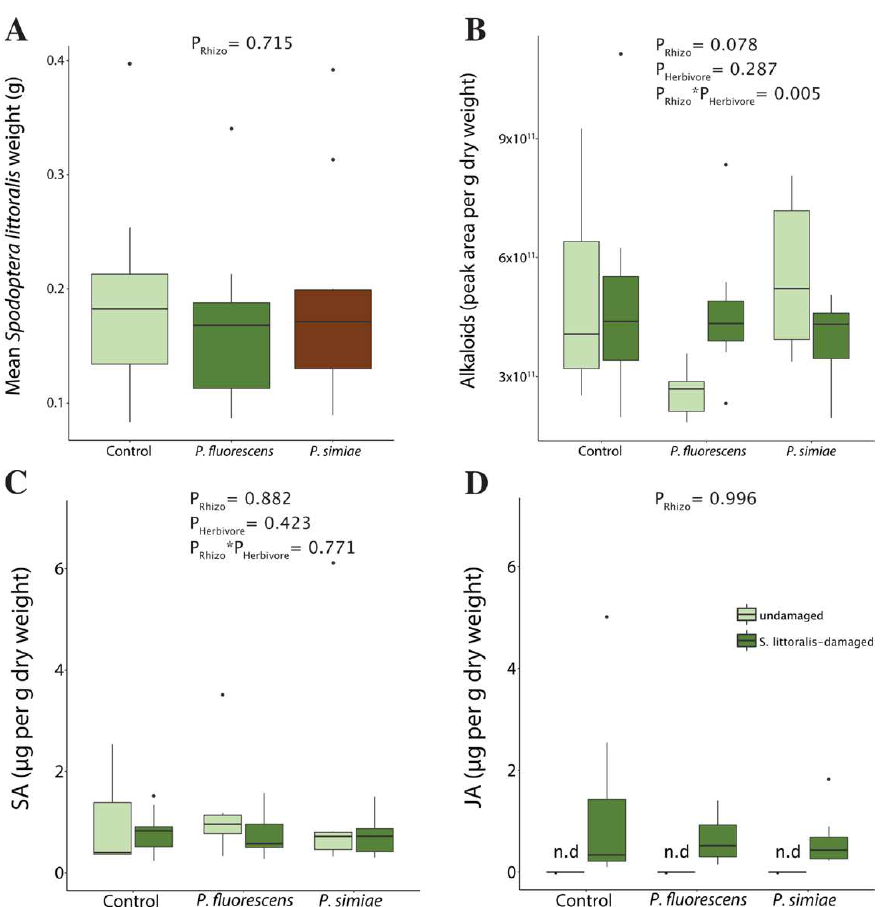
Figure 1. Caterpillar biomass, alkaloids, and phytohormones in tomato plants Solanum lycopersicum exposed to inoculation with one of two strains of rhizobacteria and herbivory by Spodoptera littoralis . ( A ) Biomass of Spodoptera littoralis larvae after a 7-day feeding period. ( B ) Levels of foliar alkaloids, ( C ) salicylic acid (SA) and ( D ) jasmonic acid (JA) in undamaged and S. littoralis -damaged leaflets of the respective treatments. Data comprises 10 biological replicates for the performance assay with S. littoralis and 5–12 replicates for the defensive metabolites. n.d. = not detected. 2.2. Inoculation with P. simiae Renders Tomato Plants Less Attractive to the Predator P.